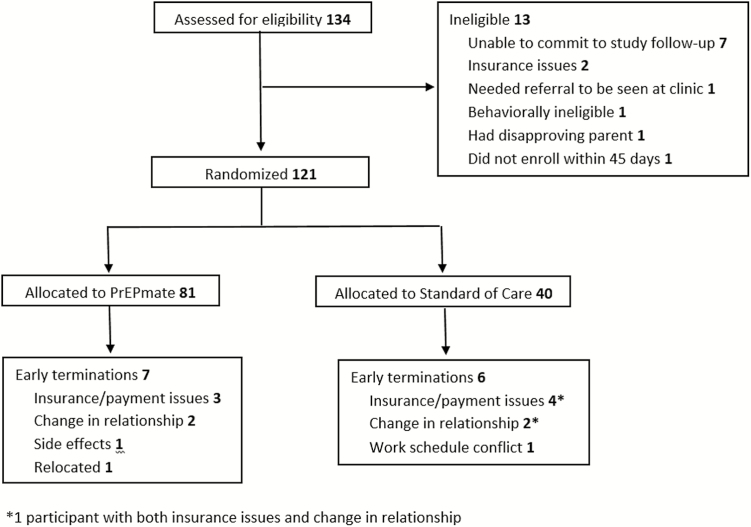
Consort diagram.